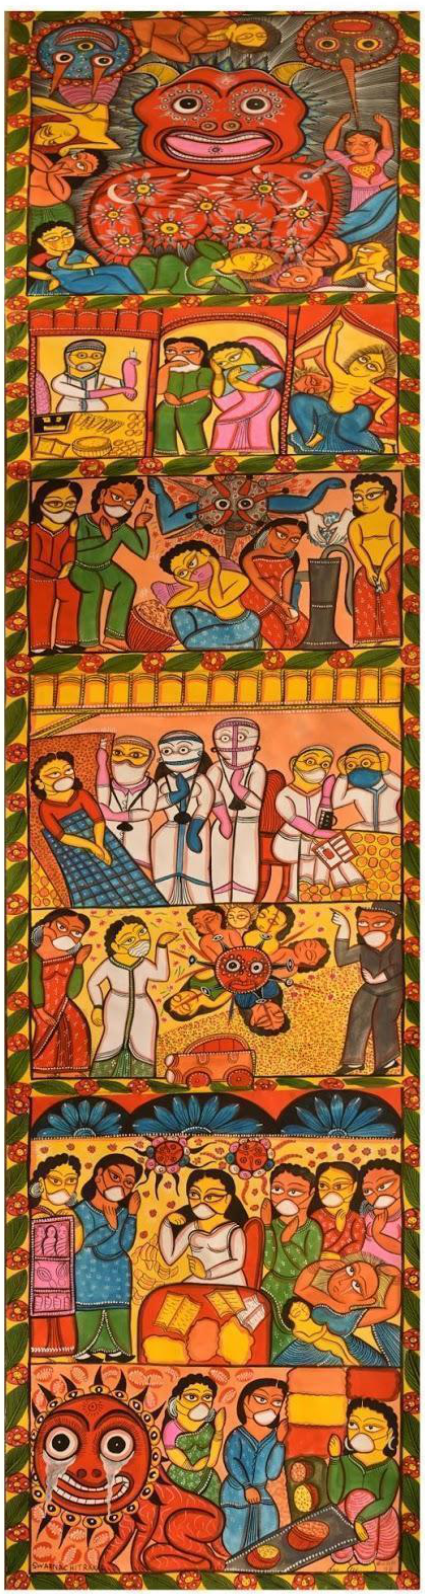
Figure 2. Swarna Chitrakar, “Coronavirus”. Commissioned by Anjali Gera Roy for Project “Folk Artists in the Time of Coronavirus”